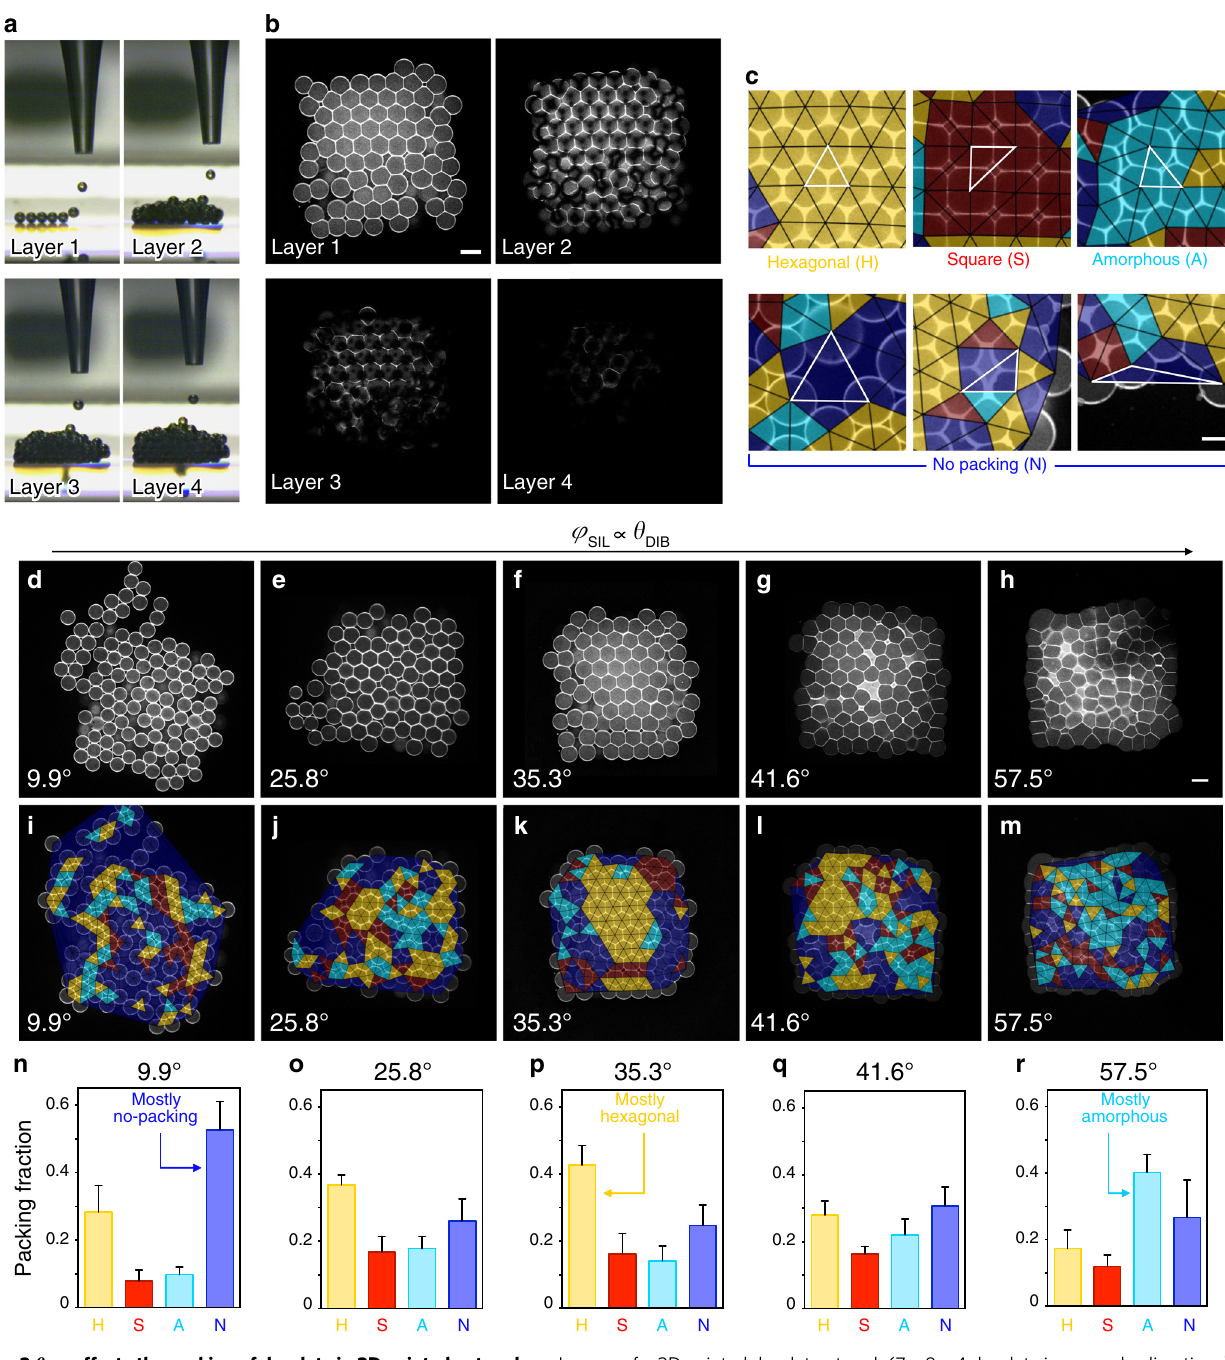
Fig. 2 θ DIB affects the packing of droplets in 3D-printed networks. a Images of a 3D-printed droplet network (7 × 8 × 4 droplets in x, y and z directions) as each layer (1 to 4) is formed. b Horizontal cross-sections of layer 1 (bottom), layer 2, layer 3 and layer 4 of a droplet network imaged by confocal microscopy. Lipid bilayers and monolayers are visualised with Atto550M. c Examples of packing types in the fi rst layer of 3D-printed networks. Our classi fi cation method draws triangles (indicated by black and highlighted white triangles) between the centres of three neighbouring droplets and assigns the local packing type of each triplet based on the triangle geometry (Delaunay triangulation). Droplet triplets are classi fi ed as packed in a hexagonal (yellow), square (red) or amorphous (cyan) fashion, or not packed (blue) (see “ Methods ” ). d – m Confocal microscopy images ( d – h ) and overlays of the packing analysis based on Delaunay triangulation ( i – m ) of the fi rst layer of 3D-printed droplet networks at increasing φ SIL values (corresponding to increasing θ DIB ). Yellow, red, cyan and blue triangles represent the packing types de fi ned as hexagonal, square, amorphous and no packing, respectively. Scale bar = 100 µ m. n – r Quanti fi cation of hexagonal (yellow), square (red), amorphous (cyan) and no-packing (blue) area fractions in the fi rst layer of 3D- printed droplet networks at increasing values of φ SIL . In n – r , each bar is the mean of n > 3 networks (see Supplementary Table 21 for individual n values and Supplementary Fig. 3); error bars represent the standard